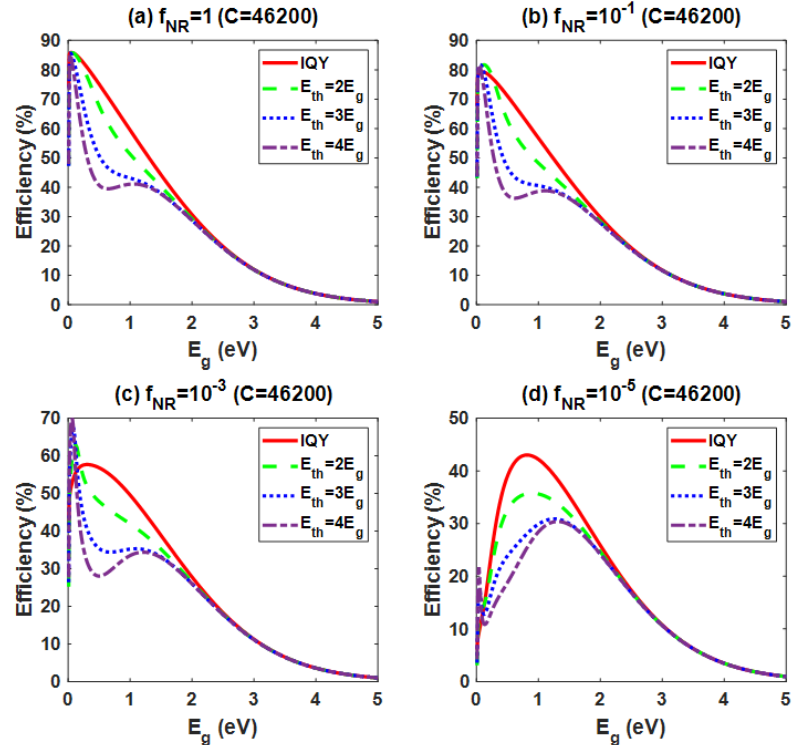
Figure 5. E g vs. theoretical e ffi ciencies of the MEGSC with fixed f NR under full-light concentration (C = 46,200) For this simulation, we used IQY and NQY (E th = 2 · E g , 3 · E g , 4 · E g ). f NR is 1, 10 − 1 , 10 − 3 , and 10 − 5 ).